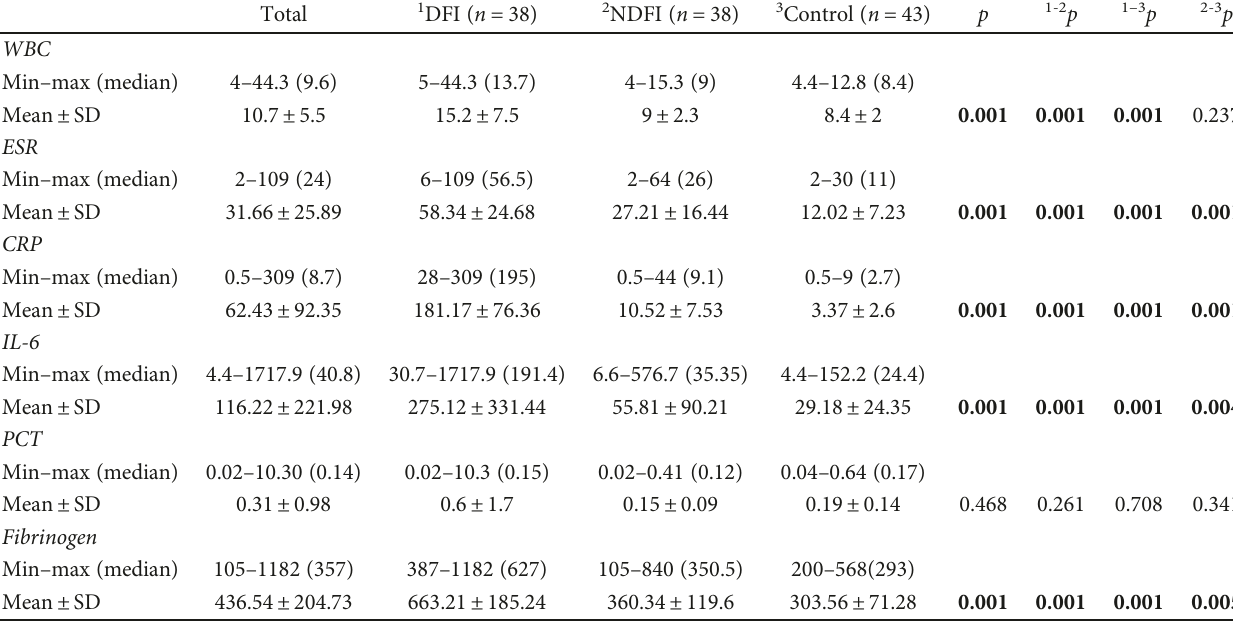
Table 3: In fl ammatory markers in infected diabetic foot ulcer (DFI), noninfected diabetic foot ulcer (NDFI), and control groups. Total 1 DFI ( n = 38